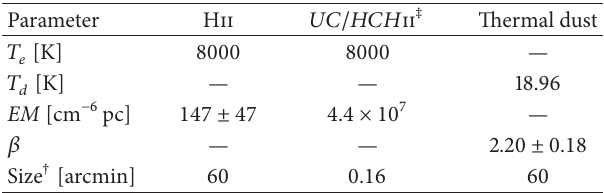
† Radius of circular aperture. ‡ Listed parameters represent the best fit values, and uncertainties are highly nonsymmetric. Table 4: Maximum likelihood parameters for spinning dust model fitted to G107.1+5.2.